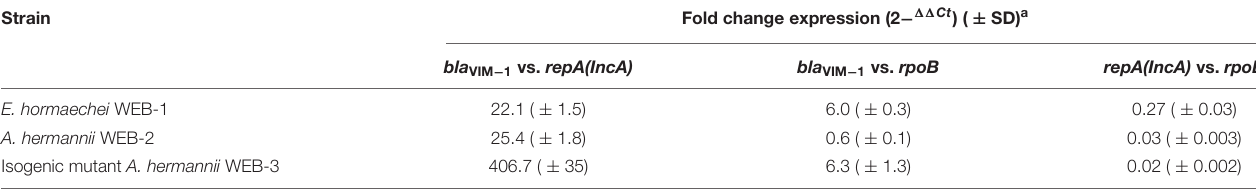
TABLE 4 | Fold change RNA transcription of bla VIM − 1 relative to that of repA(IncA) and rpoB in E. hormaechei WEB-1, A. hermannii WEB-2, and isogenic mutant A. hermannii